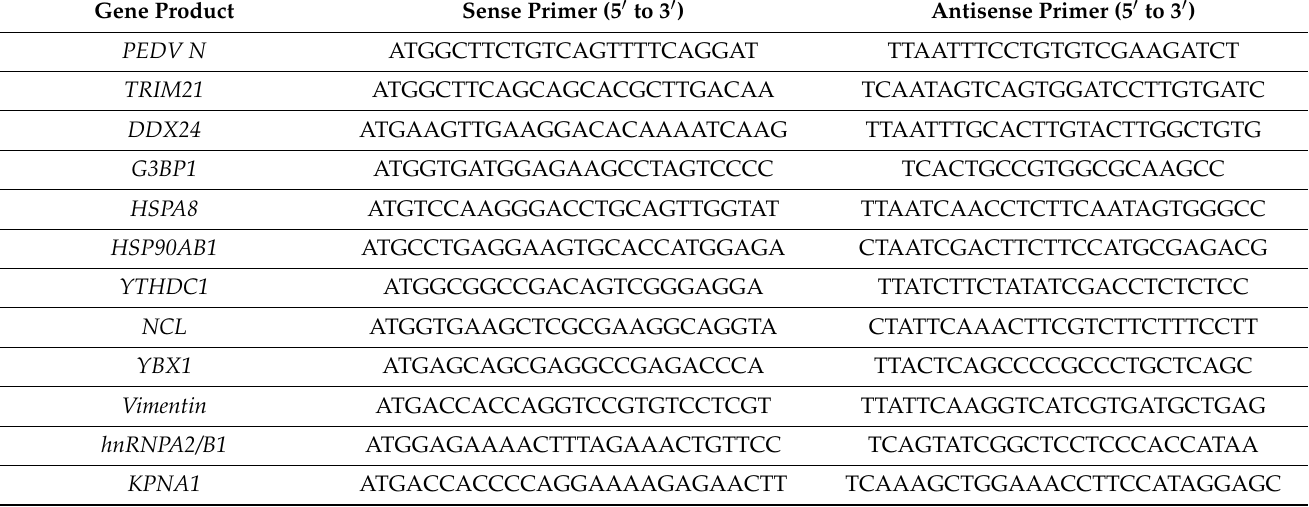
Table 1. List of primers used for cloning in the